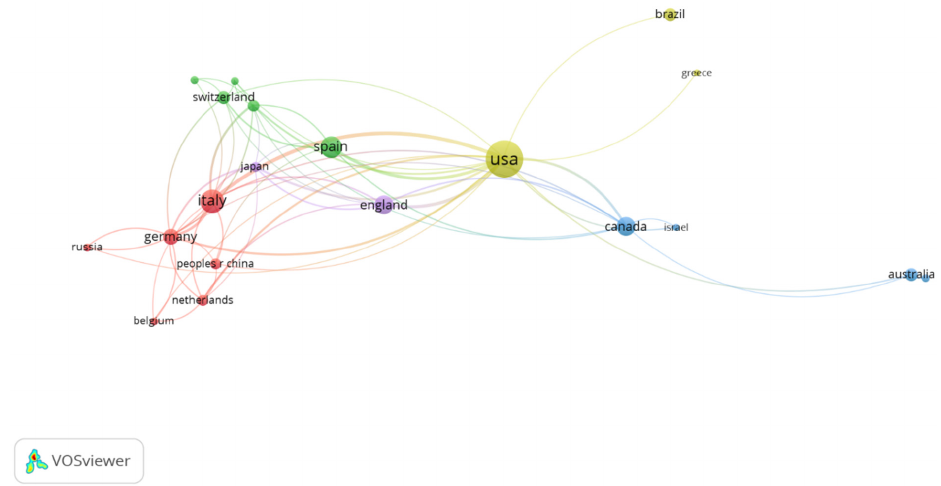
Figure 1. Collaboration between countries.